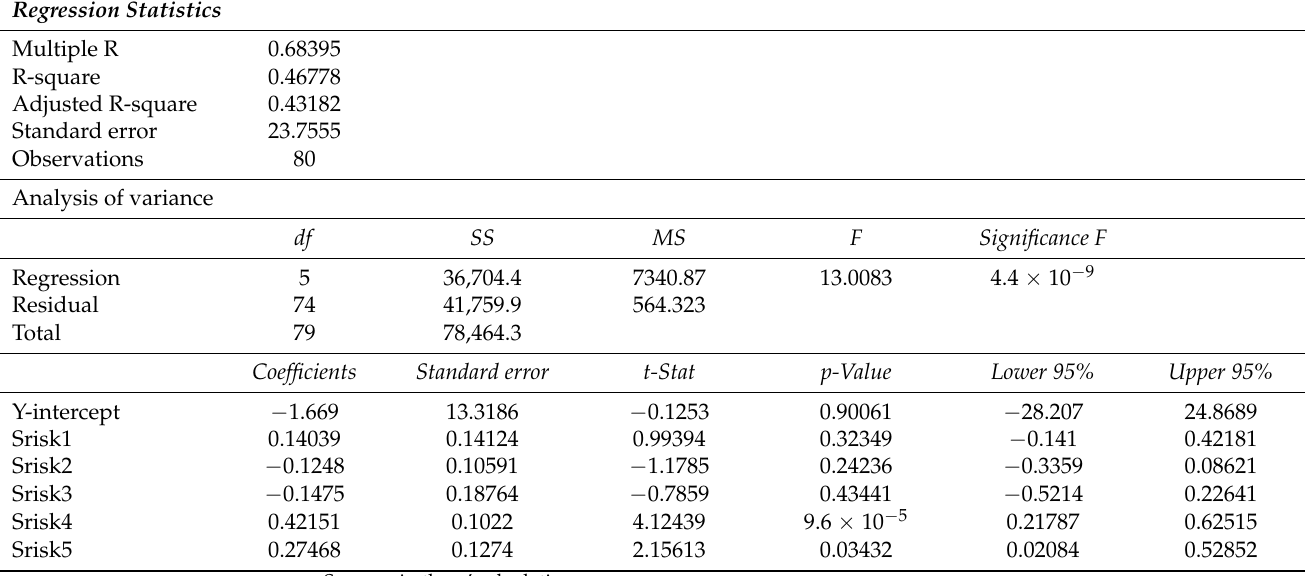
Table A13. Regression statistics of the dependence of Frisk 4 on social consequences of investments in innovation